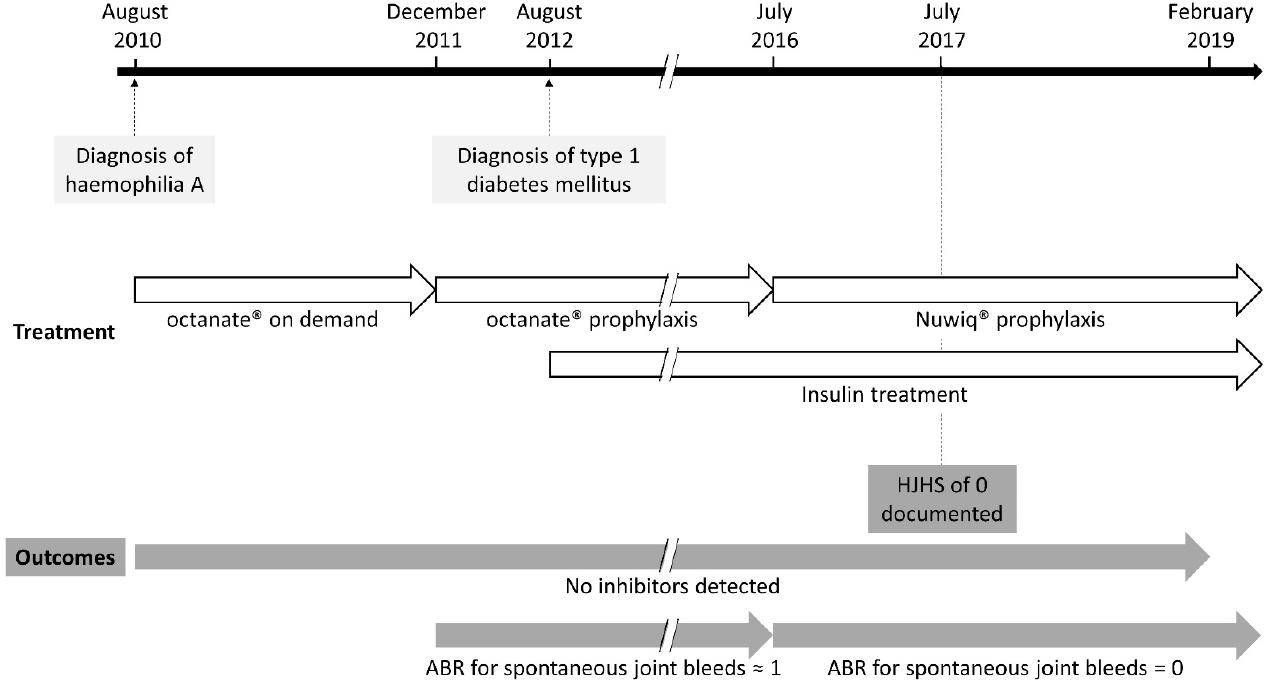
Figure 1. Timeline of key events and outcomes. Timeline of key diagnoses (light grey boxes), treatments (open arrows) and outcomes (dark grey arrows and boxes). ABR, annualised bleeding rate; HJHS, Haemophilia Joint Health Score.